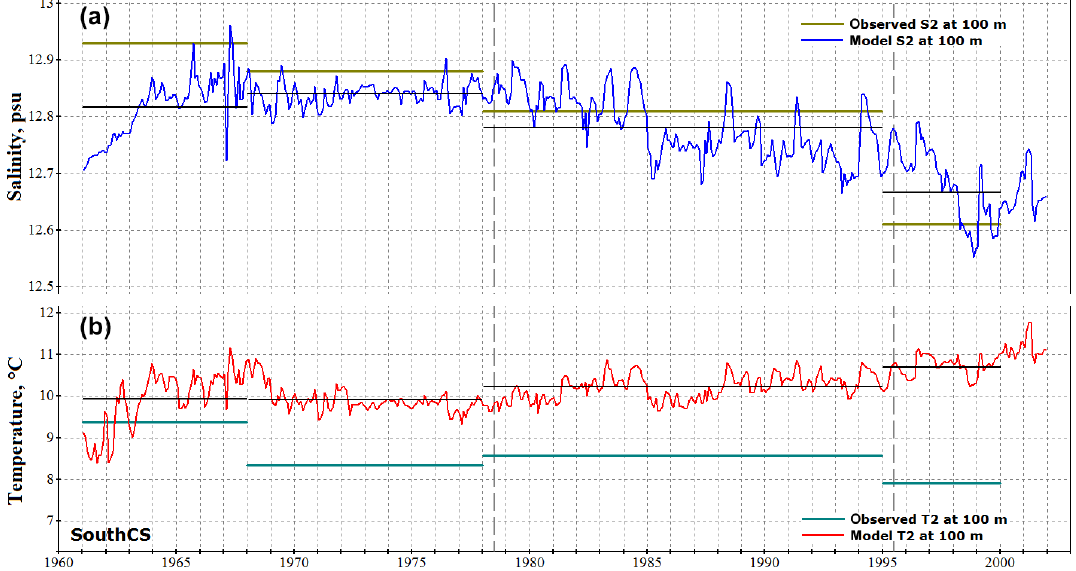
Figure 7. Same as Fig. 6 for location 2 (SouthCS; see Fig.